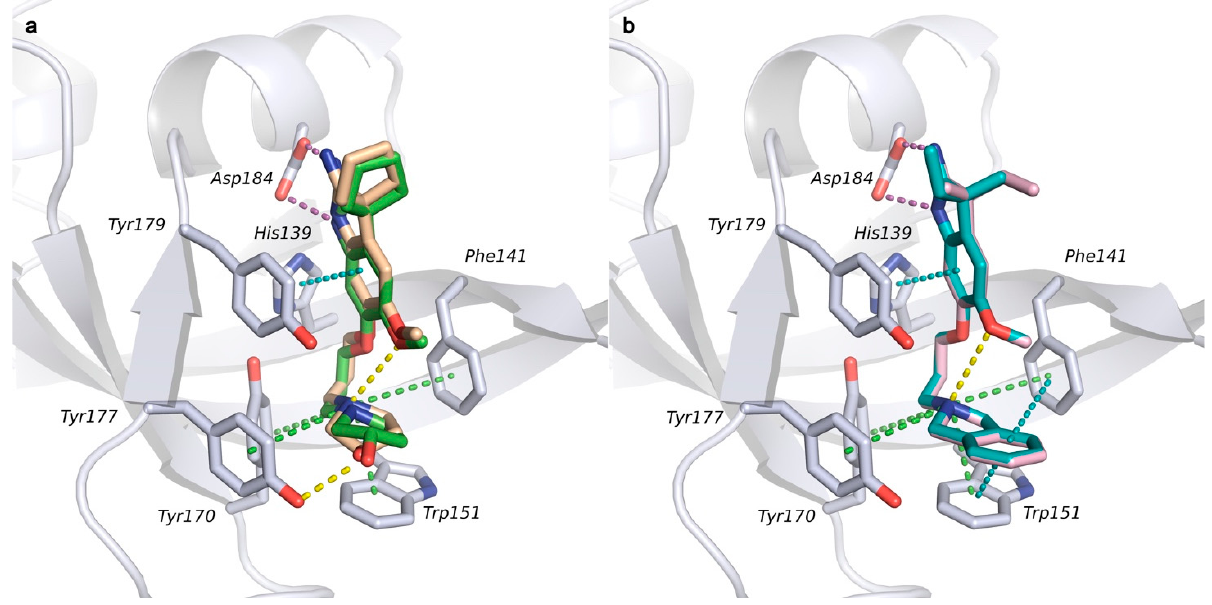
Figure 8. Predicted binding modes of some derivatives in the Spindlin1 second domain binding site (PDB ID: 6I8Y). ( a ) Compound 1q (S, green; R, beige). ( b ) Compound 1s (S, cyan; R, light pink). Docking poses and side chains of the surrounding residues are shown as sticks. Binding interactions are represented with dashed lines colored in yellow (hydrogen bond), green (cation–pi), cyan (pi–pi stacking), and magenta (salt bridge).